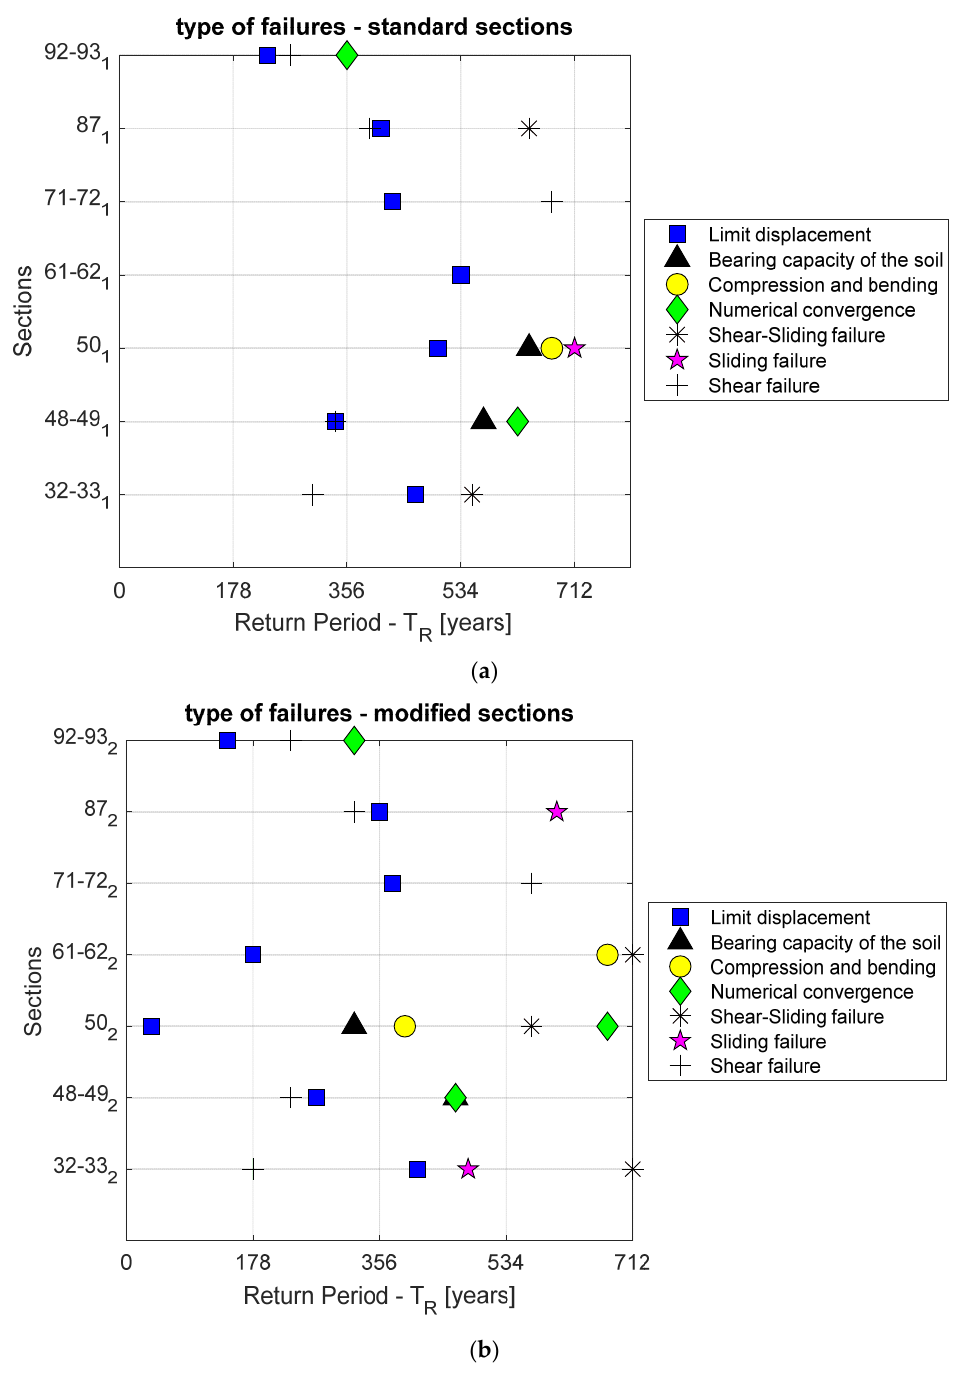
Figure 9. Types of failure for the analyzed section (NLS analysis). Standard (without imbibition) section ( a ) and modified (with imbibition) section ( b